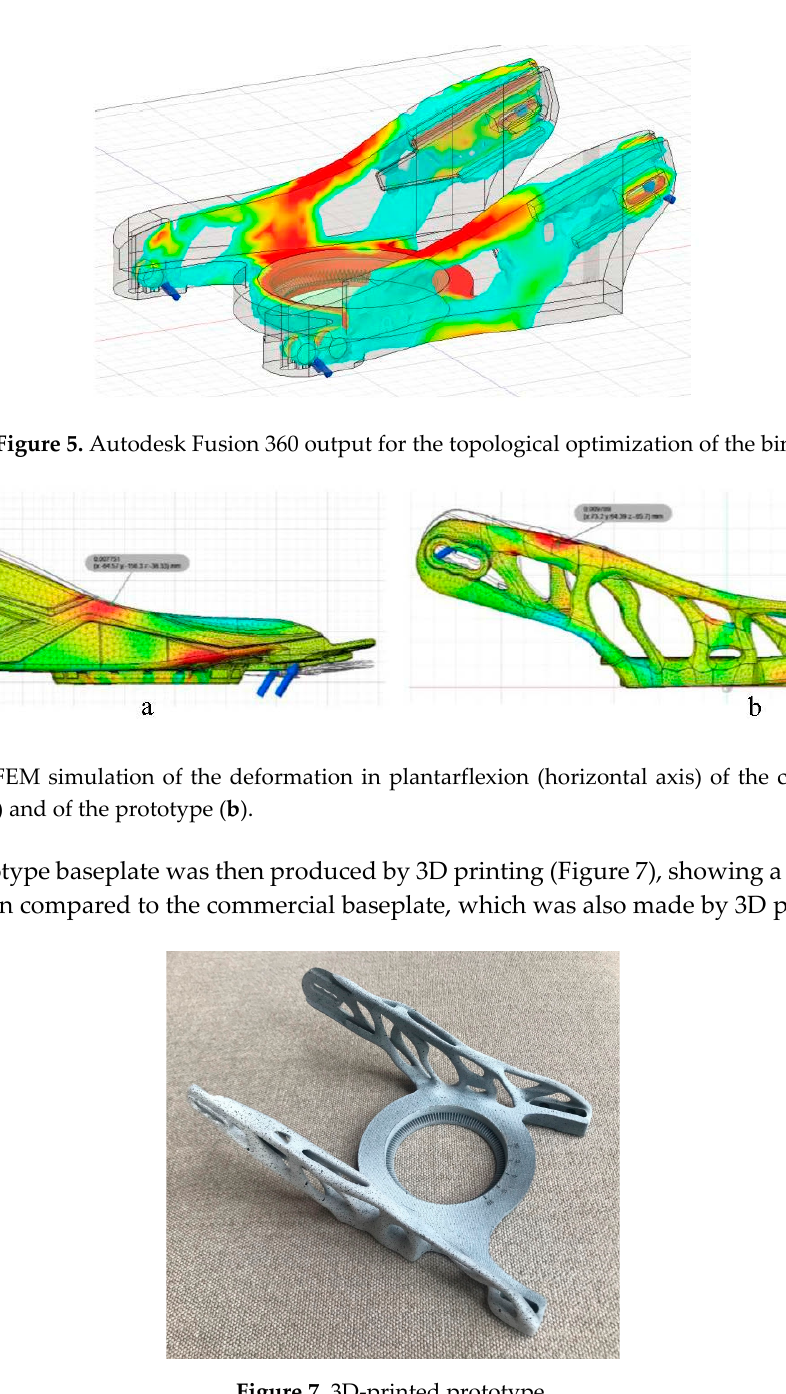
Figure 7. 3D-printed